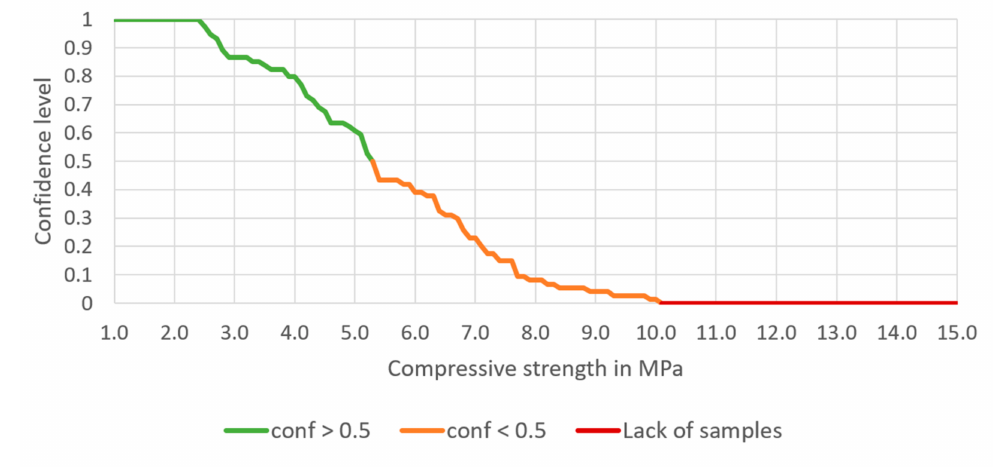
Figure 6. The dependence of the confidence of the rule on the chosen compressive strength, based on a selected aggregate